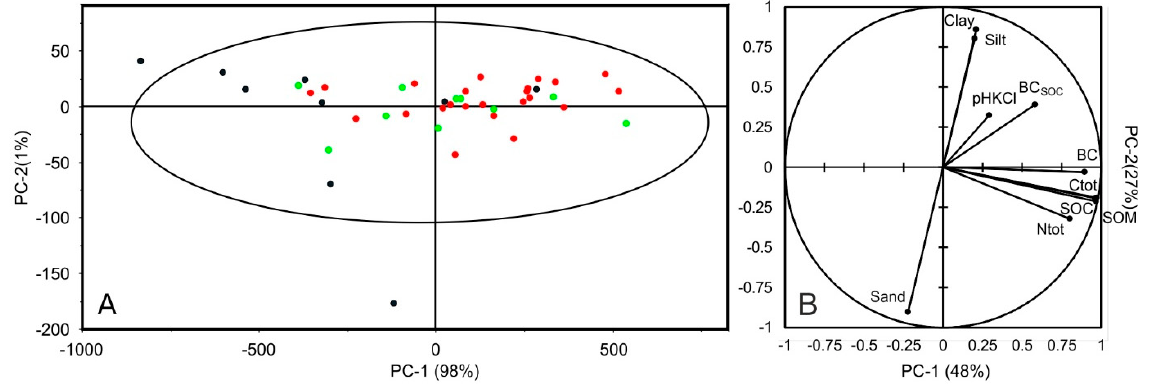
Figure 3. PCA scores with Hotelling T2 ellipse (PC-1 and PC-2) from the PCA application to soil spectra ( A ) and principal plane (PC-1 and PC-2) of the investigated soil properties ( B ). The three classes of BC content are represented as green dots—low (0–0.7 g kg − 1 ); red dots—medium (0.71–2.0 g kg − 1 ) and black dots high (>2.01 g kg − 1 ).